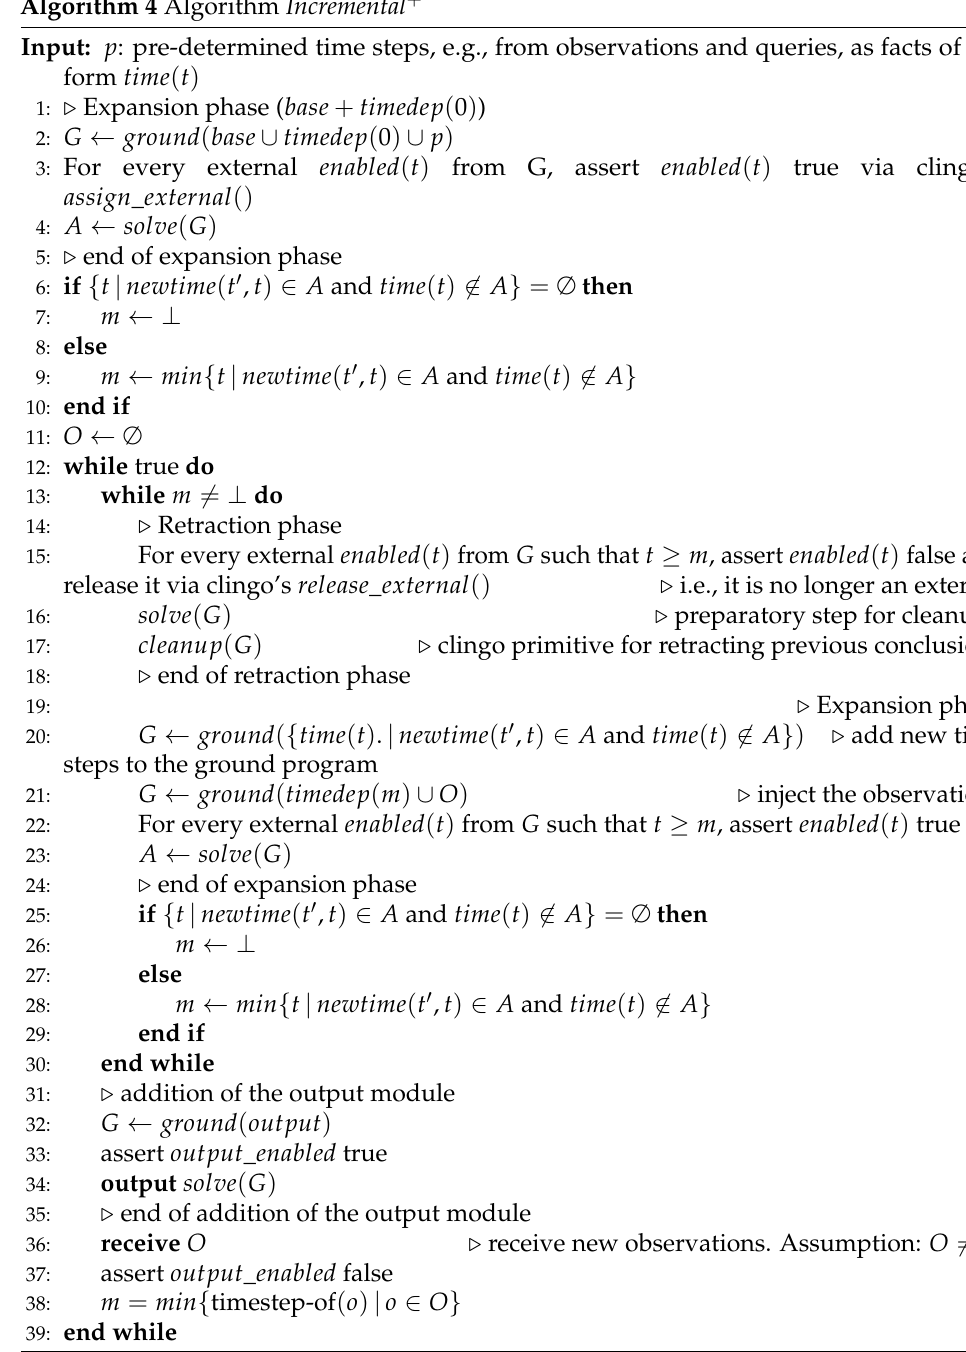
Algorithm 4 Algorithm Incremental